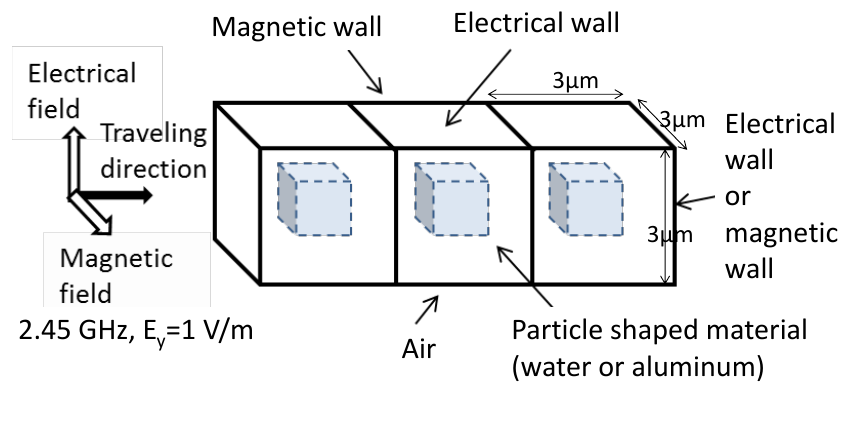
Figure 4. Micro-scale model in electromagnetic